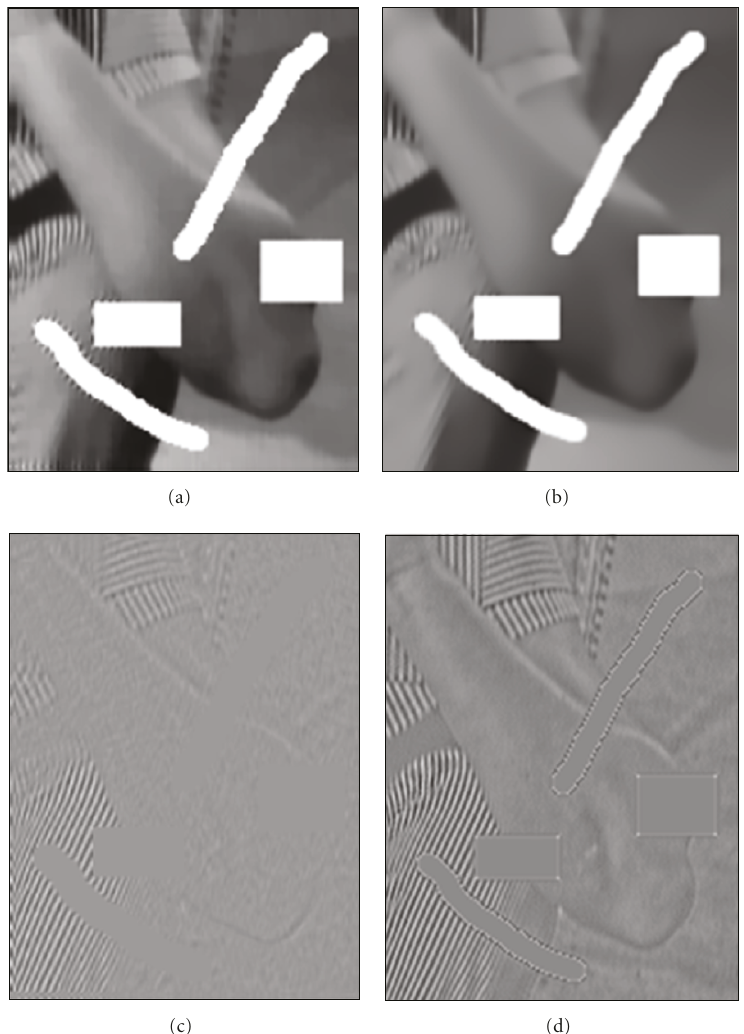
Figure 5: Closeups of decomposed components of the input image: the geometry images (a) and (b) and the texture images (c) and (d) are obtained by the method in [6] (left side) and the proposed method (right